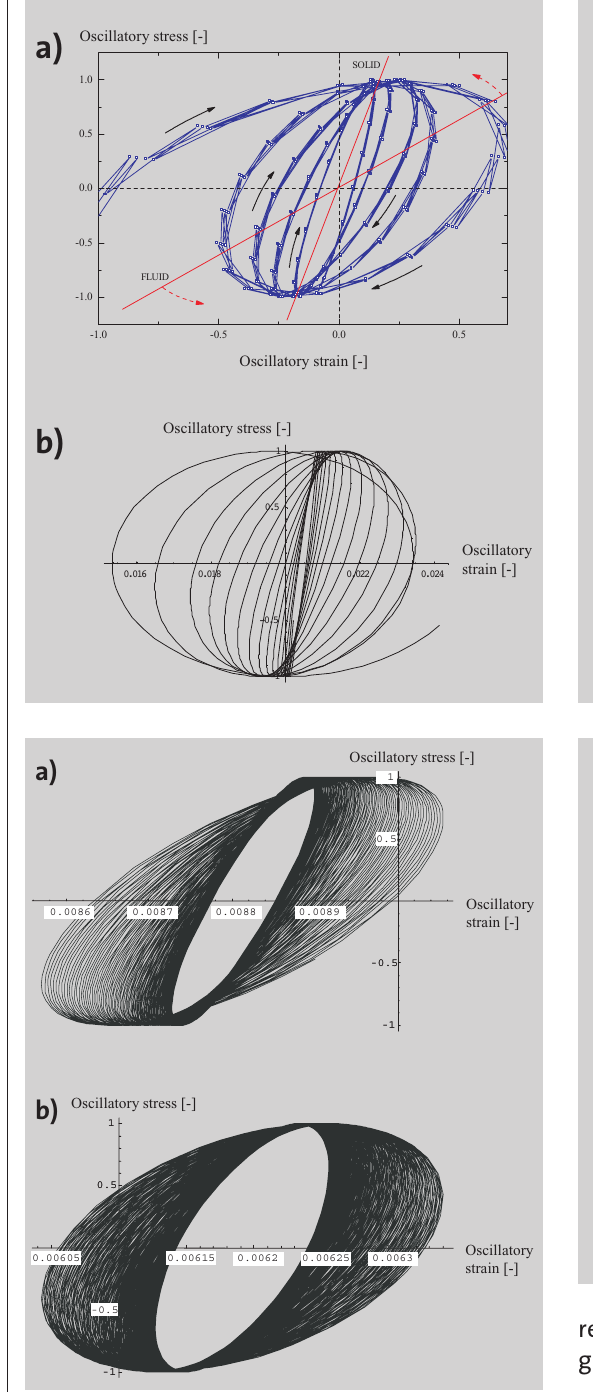
Figure 7 (left above): Experimental and theoretical Lissajous figures: oscillatory stress as function of oscillatory strain (with time parameter) associated with the dynamic test (sample S2). Figure 8 (right above): Experimental and theoretical Lissajous figures for sample S1: detail at small strain amplitudes. Figure 9 (left below): Lissajous figures, oscillatory stress as function of oscillatory strain (with time parameter), associated with dynamic test; numerical simulation of Eq.10 with t – = 1: a) w – = 10; b) w – = 50. Figure 10 (right below): Experimental non- dimensional Lissajous figure for sample S1 (It is observable the sharp rheo- logical transition from “fluid” to “solid” like behaviour, see the associat- ed Fig.